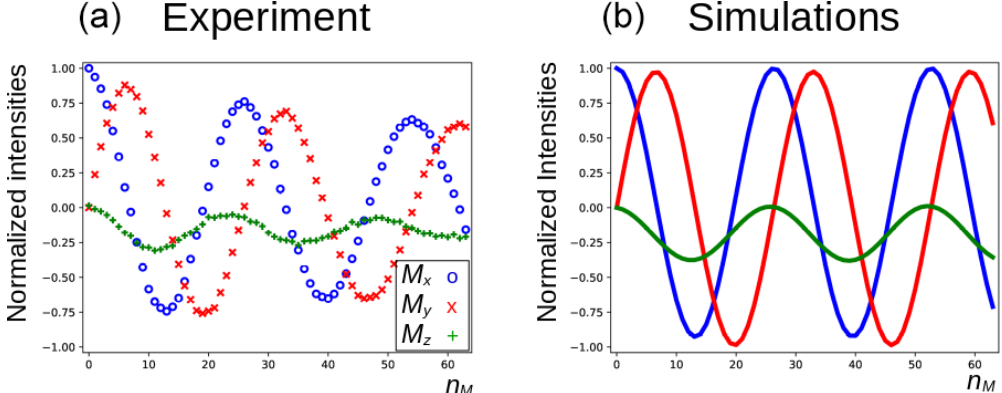
Figure 5. Evolution of the magnetization of the methyl resonance of DSS under the experimental conditions shown in Fig. 4 (curve a ). For the calculations in panel (b) , the RD rate and angle were set to R R = 33 . 4 × 2 π rads − 1 and ψ = 30 ◦ ,